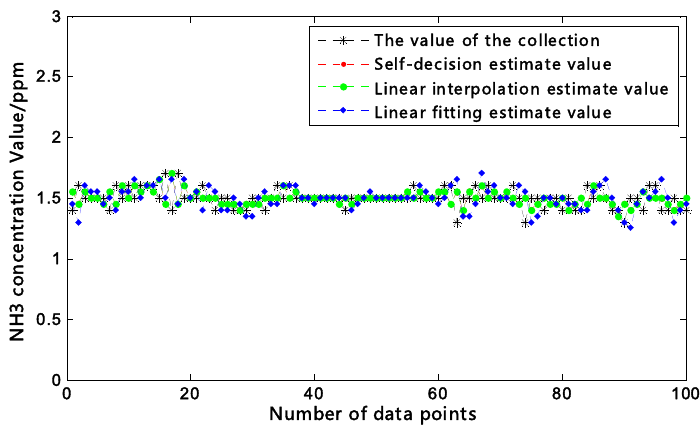
Figure 10. Comparison of the experimental results and the estimated concentration of CO 2 of Node A.